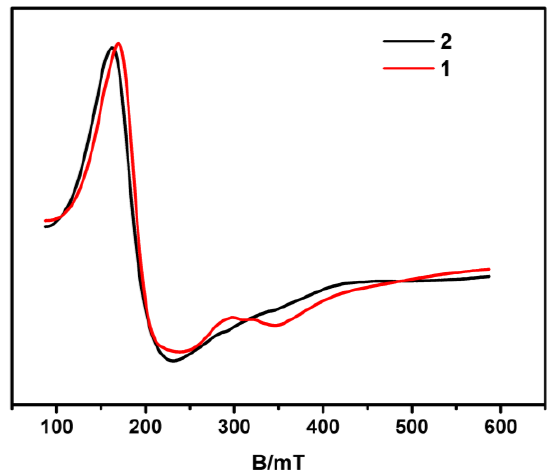
Figure 1. Electron paramagnetic resonance (EPR) spectra of the crystalline samples of complex 1 and 2 at room temperature and v = 9.07 GHz. Broad intense transitions are observed at 168 and 162 mT resonance fields, respectively. Table 2. Selected Bond length for 1 and 2 .